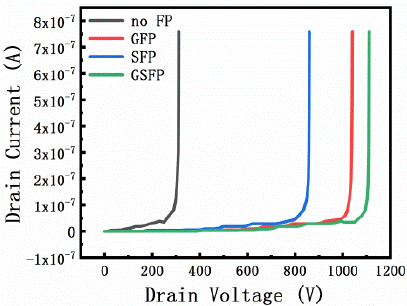
Figure 11. Breakdown voltage of devices with different field plate types.